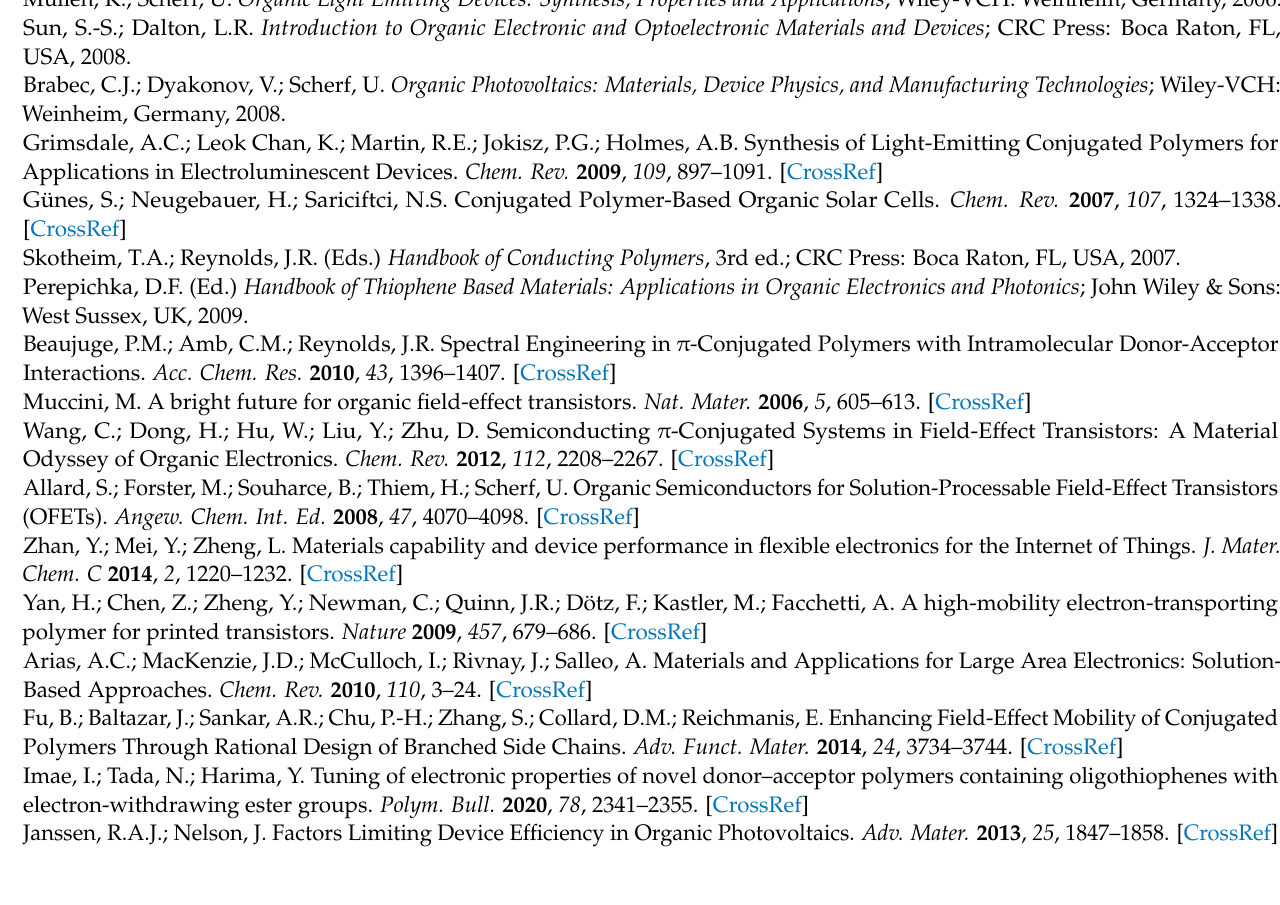
Figure S5: 1HNMR spectrum of P(FDPP-TP) polymer. Figure S6: DFT calculation data of Spartan 16 software (B3LYP/6-31G*). Figure S7: OFET transfer curves (a-d) and output curves (e-h) of bottom- gate top-contact devices: (a,e) RT, (b,f) 100 ◦ C, (c,g) 150 ◦ C, and (d,h) 200 ◦ C. Figure S8: OFET transfer curves (a,b) and output curves (c,d) at 225 ◦ C of (a,c) BGBC and (b,d) BGTC. Figure S9: (a) DSC thermogram and (b) TGA thermogram of P(FDPP-TP) . Figure S10: GIXRD pattern of P(FDPP-TP) thin films on SiO 2 substrates at different temperatures. The crystallite sizes considering (100) peak from XRD patterns were calculated by using Scherrer formula as 7.44 nm, 7.53 nm, 8.91 nm, and 9.23 nm for samples not annealed, annealed at 100 ◦ C, annealed at 150 ◦ C, and annealed at 200 ◦ C, respectively [47]. Table S1: Optoelectronic properties of P(FDPP-TP) . Table S2: BGBC OFET data of P(FDPP-TP) . Table S3: OFET data of BGTC devices of P(FDPP-TP)